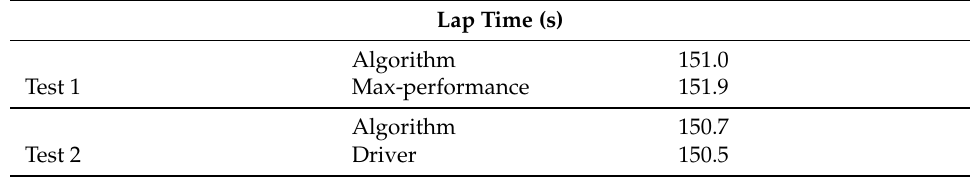
Figure 9. Accelerations performance comparison. Table 4. Lap time